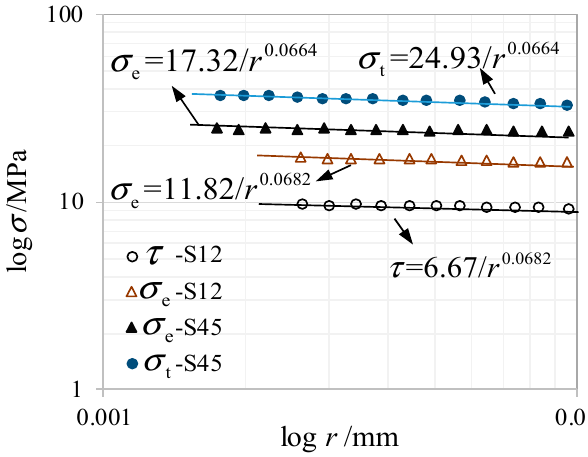
Figure 10. Stress singularity at maximum stress state.